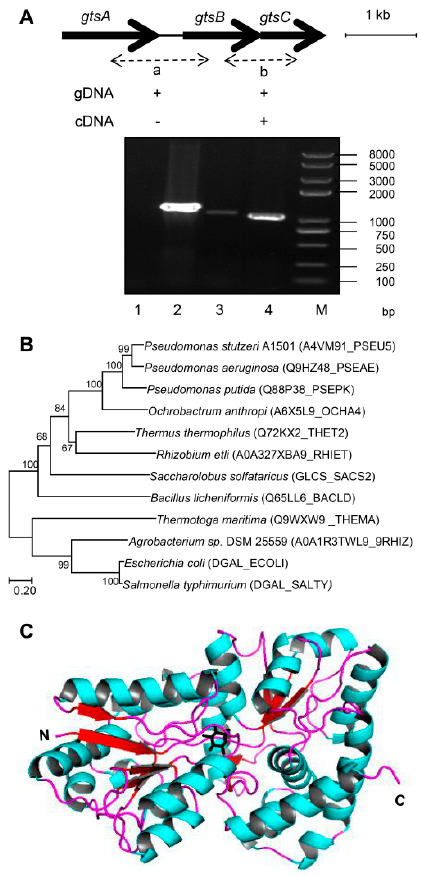
Figure 3. Gene organization of gtsABC operon, phylogenetic analysis and proposed structure of GtsA. ( A ) Independent transcription of the gtsA locus genes determined with RT-PCR. The gtsA–gtsB (a, lanes 1 and 2) and gtsB–gtsC (b, lanes 3 and 4) junctions were amplified using genomic DNA (gDNA, lanes 2 and 4) and cDNA (lanes 1 and 3) as the template. Lane M, 2 kb plus DNA ladder and the sizes of the molecular markers are indicated at the side in bp. ( B ) Unrooted neighbor-joining phylogenetic tree of the P. stutzeri A1501 GtsA was constructed after the multiple alignment of data by ClustalX [14]. Bootstrap values based on 1000 replications are listed as percentages at branching points. ( C ) Homology model of the GtsA involved in the regulation of glucose transport pathways. The N- and C-terminal domains are shown, and glucose is represented by a black stick. The figure was generated using Swiss-Model (https://swissmodel.expasy.org/) and PyMOL (http://www.pymol.org).